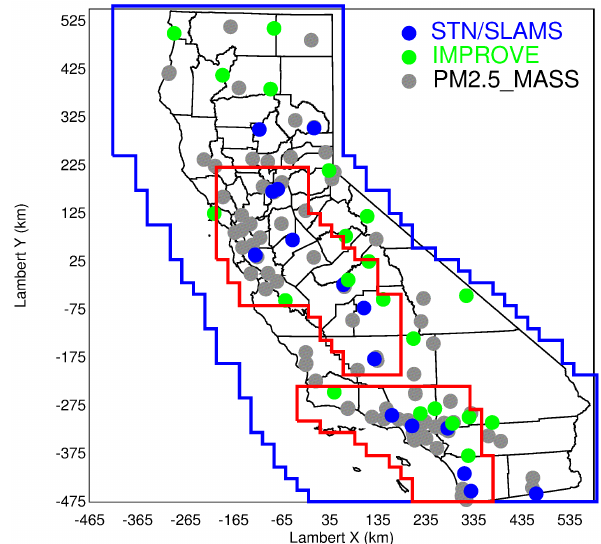
Figure 1. Modeling domains (blue lines outline the CA_24km domain, and red lines outline the SoCAB_4km (bottom) and SJV_4km domains (top)) and PM measurement sites (dots). Blue dots represent the sites of the PM 2 . 5 Speciation Trends Network (STN) and the state and local air monitoring Stations (SLAMS), green dots represent the Interagency Monitoring of Protected Vi- sual Environments (IMPROVE) sites; gray dots represent the PM 2 . 5 federal reference method (FRM)